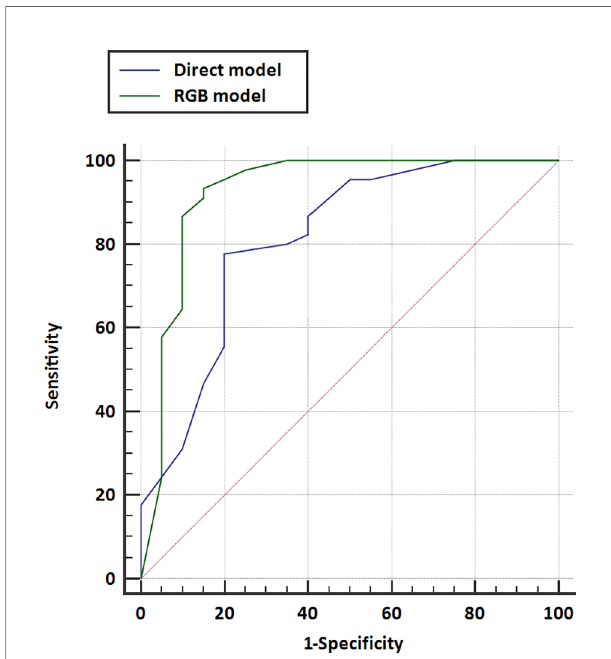
FIGURE 3 | Receiver operating characteristic (ROC) curves for the direct model and RGB model were performed in the validation cohort. The area under the curve for direct model US and RGB model were 0.813 (95% CI, 0.697 – 0.899) and 0.926 (95% CI, 0.833 – 0.976),